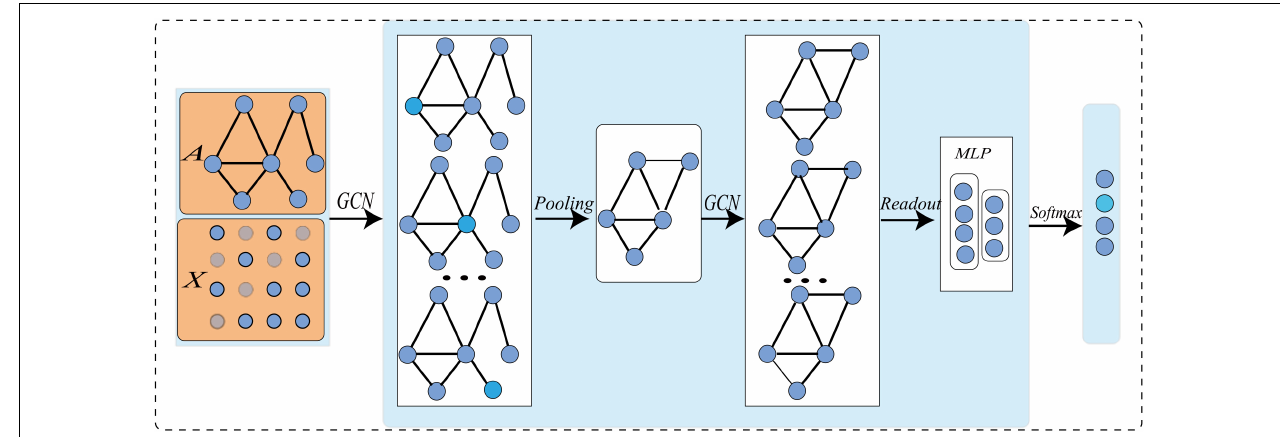
FIGURE 1 | GCN with pooling layer and readout layer for graph level